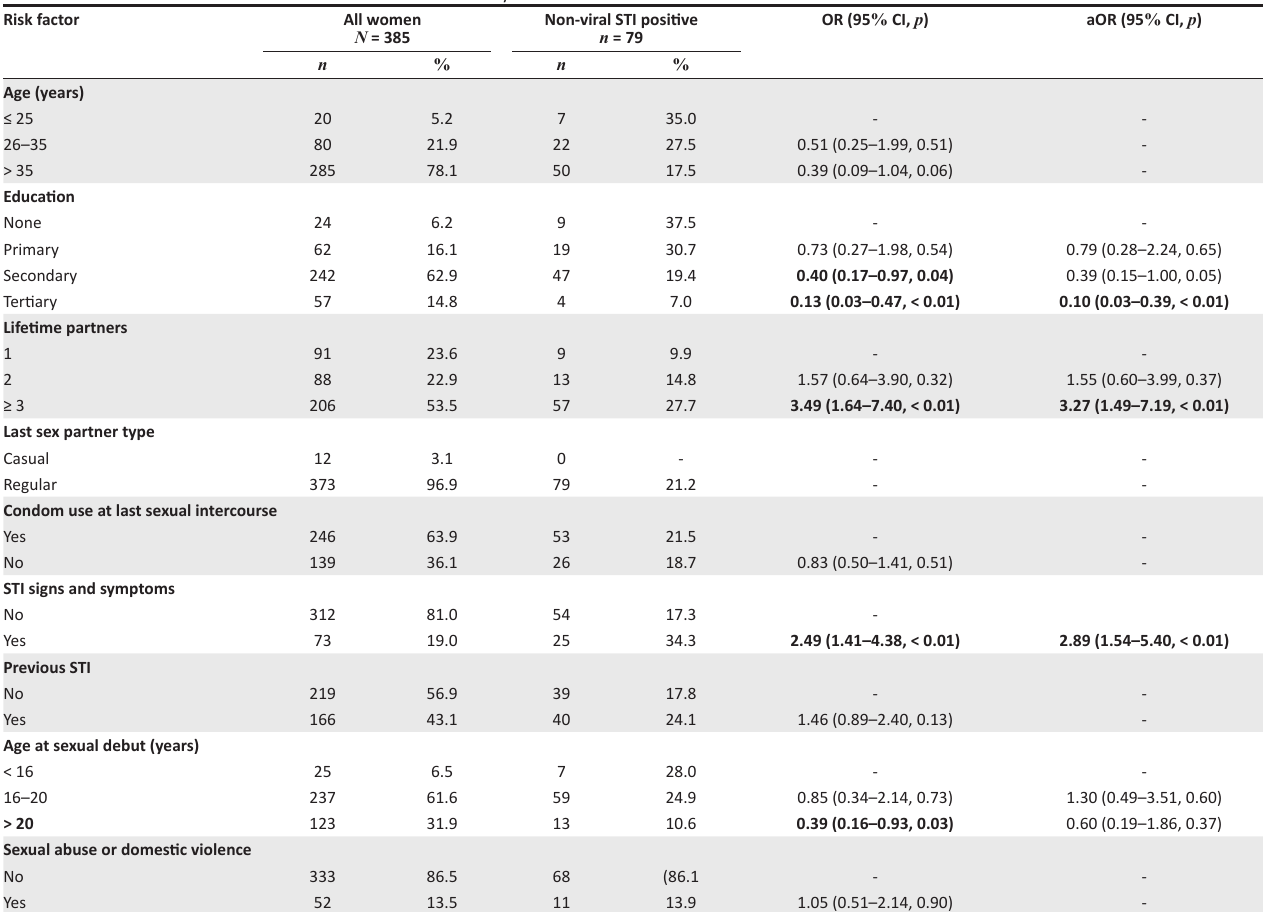
TABLE 2: Patient characteristics as risk factors for non-viral sexually transmitted infections. Risk